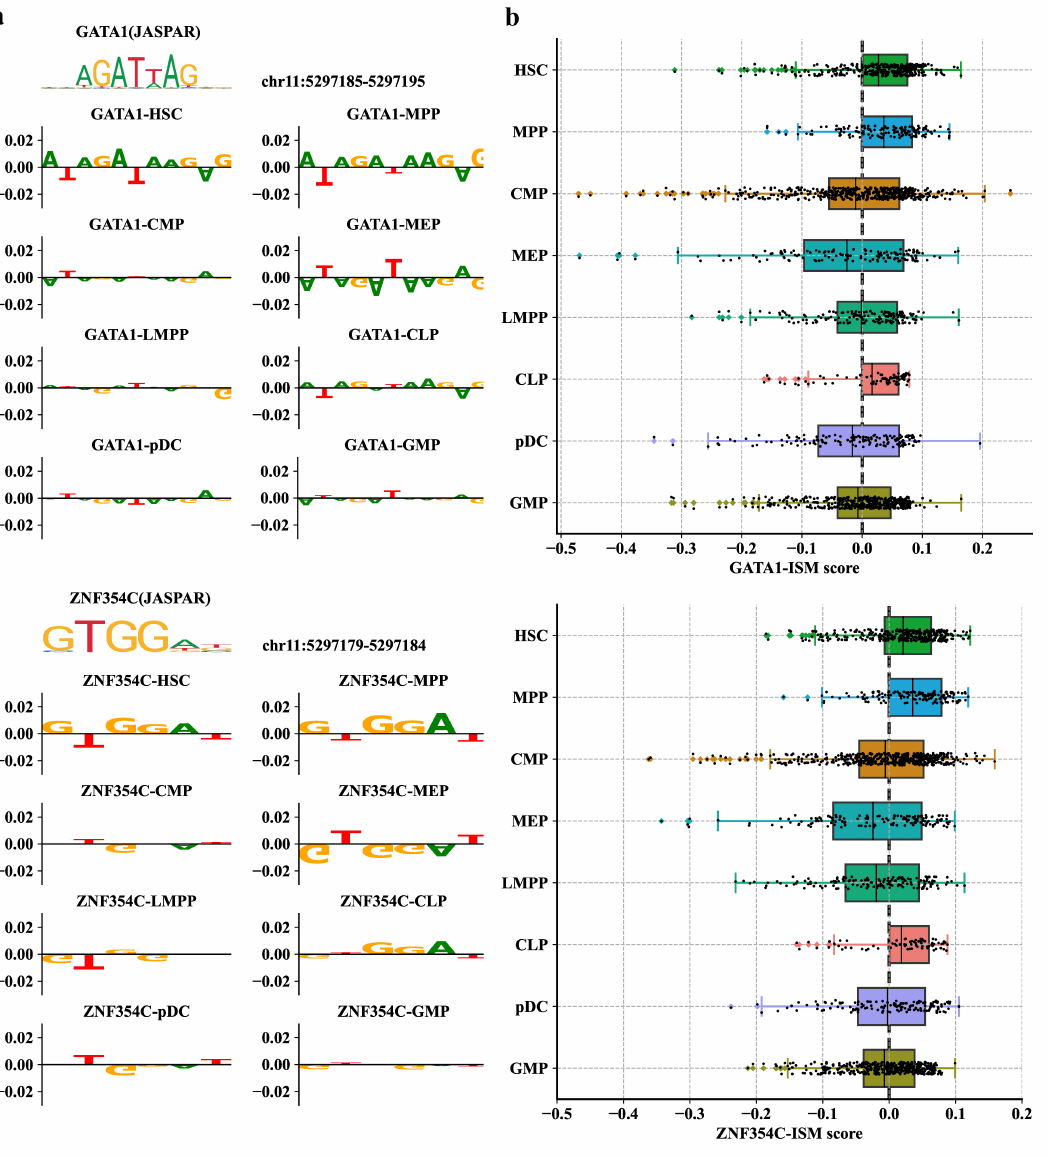
Figure 6. Performance of PROTRAIT in inferring single-cell and single-nucleotide TF activity. ( a ) ISM scores for sequences that match GATA1 and ZNF354C motifs in eight cell types. ( b ) Distributions of single-cell PWM-ISM scores for GATA1 and ZNF354C in eight cell types. The PWM-ISM score is the dot product of the PWM and ISM measurements of motif